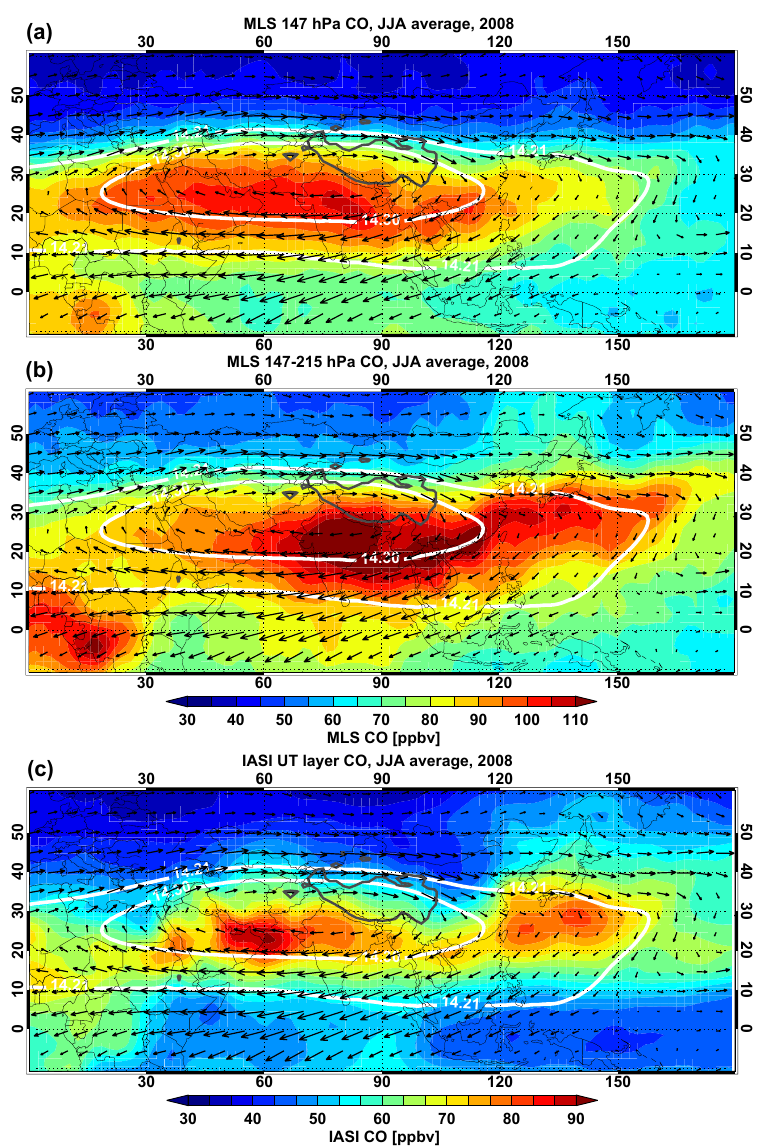
Figure 4. JJA 2008 seasonal average CO mixing ratio for (a) MLS 147hPa, (b) the MLS 147 and 215hPa average, and (c) the IASI UT layer. Superimposed white contours are the 14.3 and 14.2km GPH (from GFS analysis) at 150hPa. Note that the color scales for IASI and MLS CO are different. Both MLS and IASI are 2 ◦ × 2 ◦ longitude–latitude binned